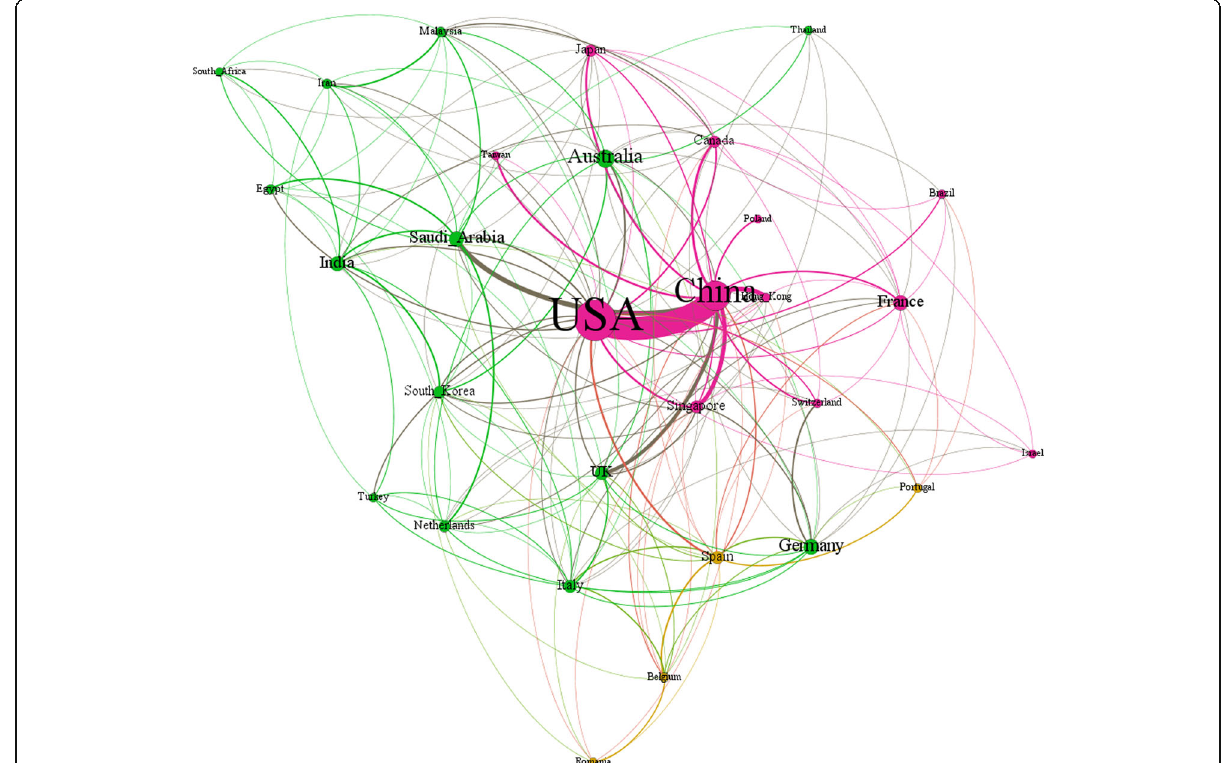
Fig. 2 The cooperation network of the top 30 productive